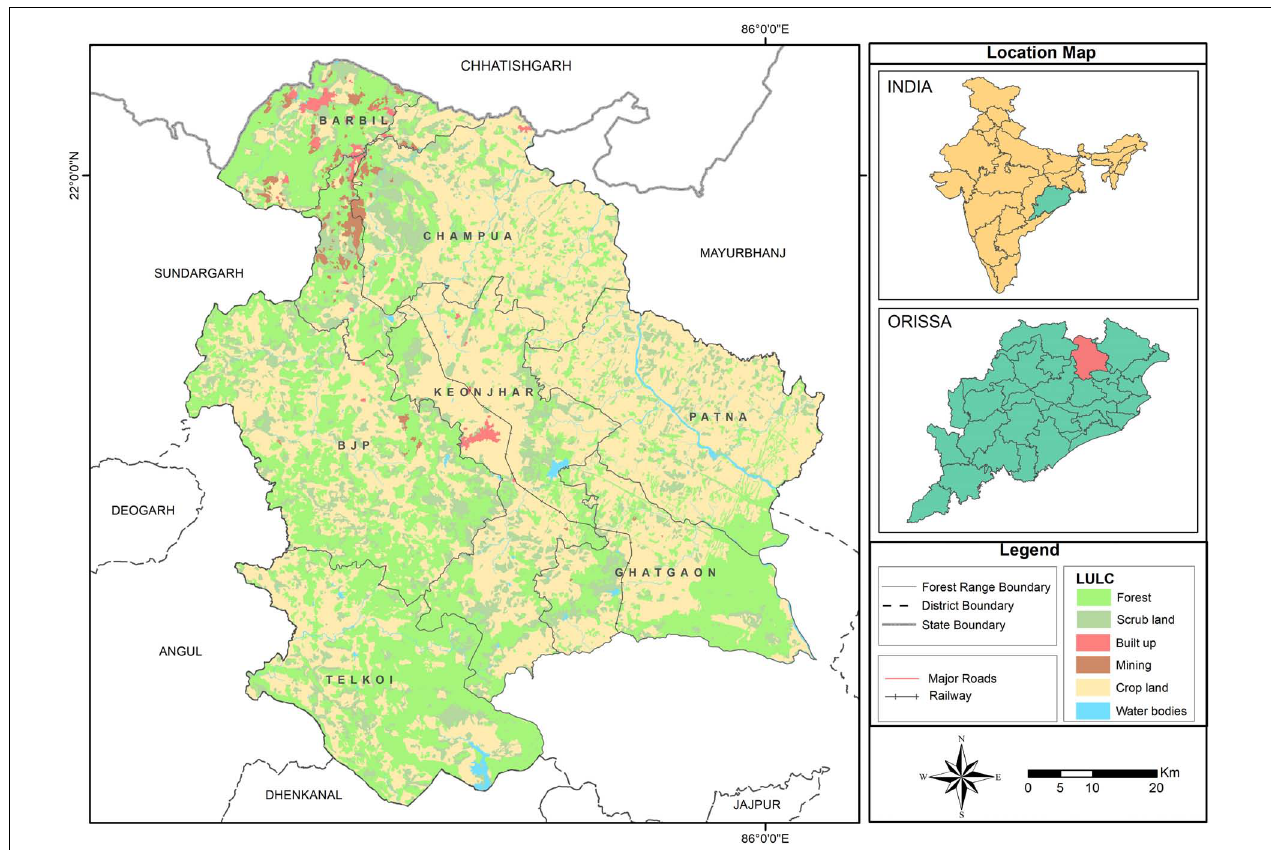
FIGURE 1 | Map showing the land cover and land use of the study area comprising forests, scrub land, built up areas, mining, crop land, water bodies and transportation networks. Keonjhar District has seven-forest ranges: (1) Barbil, (2) Bhui yan-Juang Pihra (BJP), (3) Champua, (4) Ghatgaon, (5) Keonjhar, (6) Patna, and (7) Telkoi. Source: Keonjhar Forest